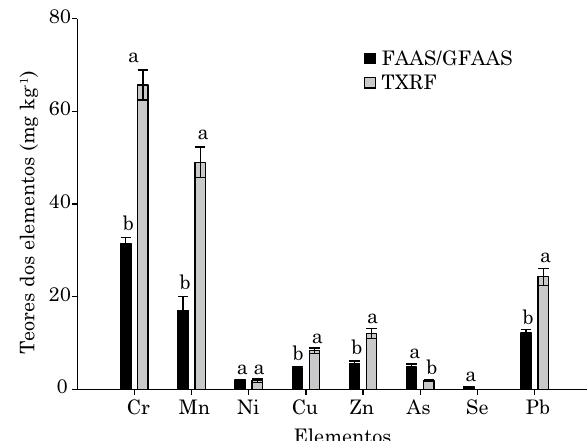
Figura 2. Teores médios de alguns elementos-traço, quantificados por espectrometria de absorção atômica de chama ou forno de grafite (FAAS/ GFAAS) e espectrometria de fluorescência de raios-X por reflexão total (TXRF), em solos coletados no Estado de mato